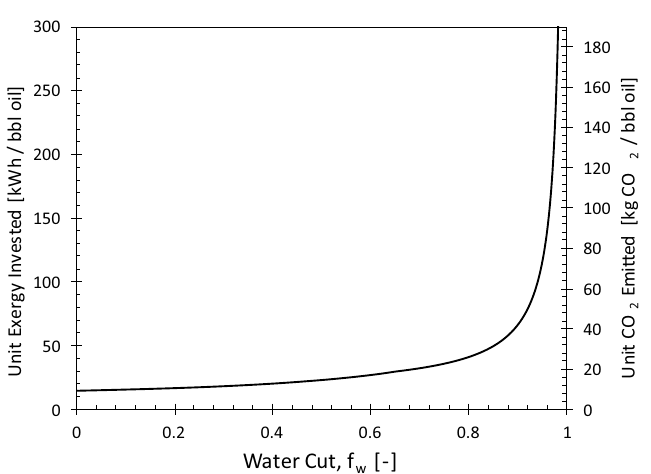
Figure 3. Unit exergy consumed and CO 2 emitted as functions of water cut for the water-injection